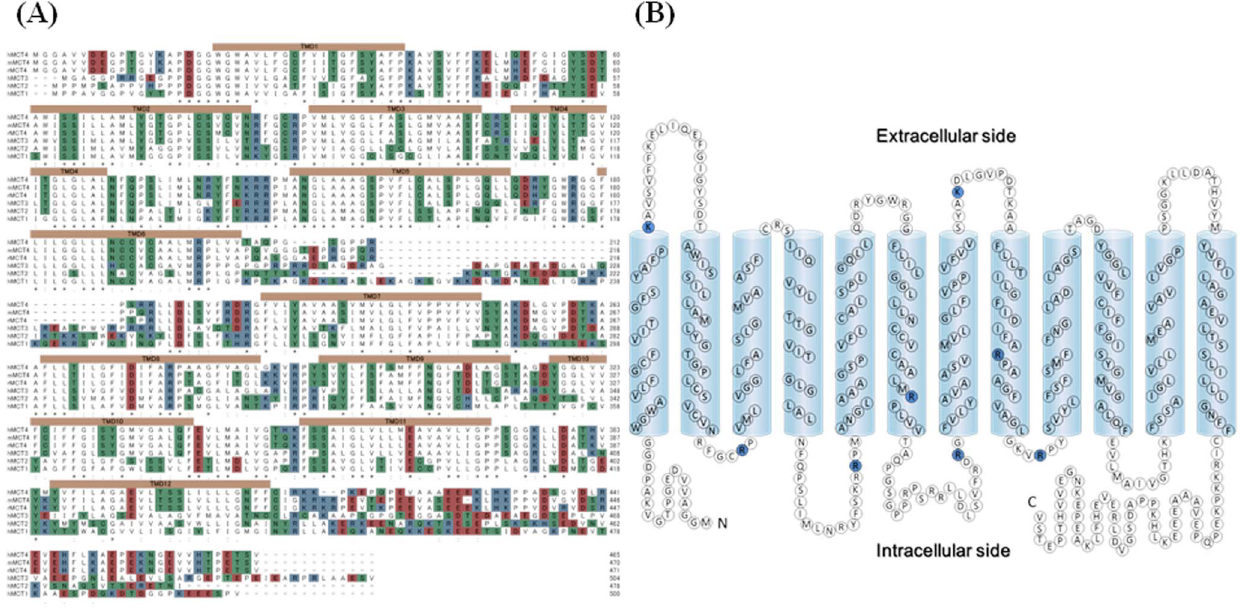
Figure 6. Sequence alignment and secondary structure of hMCT4. (A) Amino acid sequence alignment of human MCT4 with human MCT1, MCT2 and MCT3, rat MCT4 and mouse MCT4 transporter homologues using ClustalW. Orange bars in hMCT4 above the sequence are the regions predicted to from transmembrane-spanning domains (TMDs) by TMHMM. Polar residues are highlighted in red (acidic residues), blue (basic residues) and green (neutral residues). Identical residues are indicated by asterisks (*) represents under the residue. (B) Putative topology of hMCT4: The conserved basic residues of MCT1-4 are shown in blue.